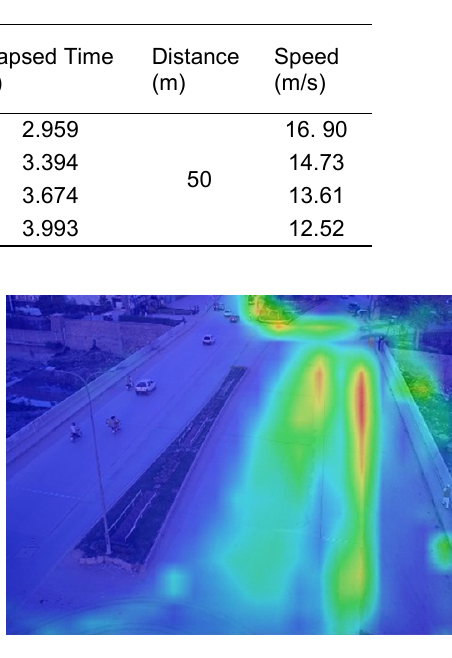
Figure 10. Vehicle density map on a 50 m University Road section over a period of 1442 s.